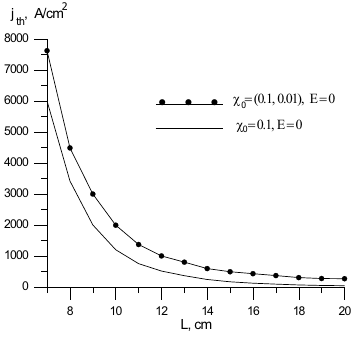
Figure 3. Electron beam current threshold in Bragg